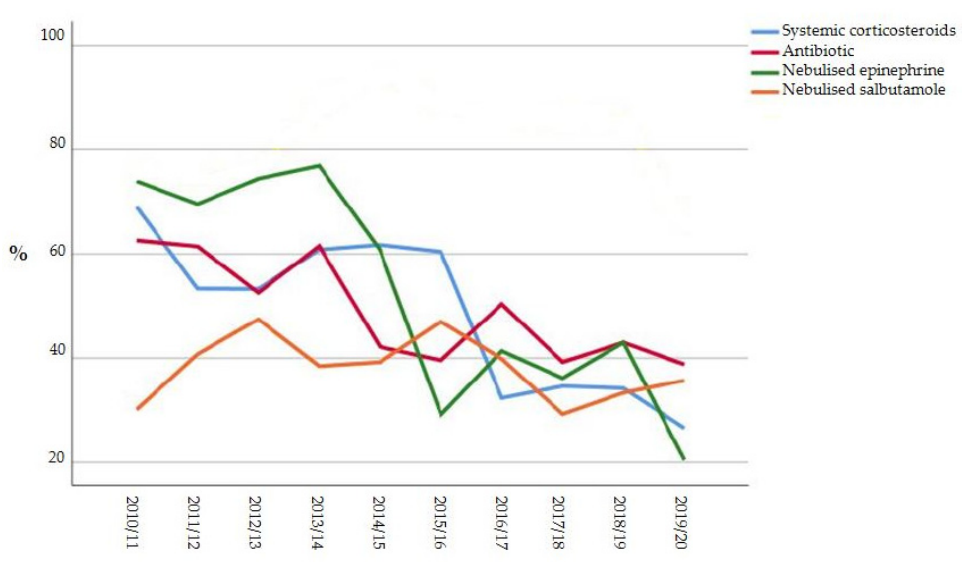
Figure 1. Variation in the use of pharmacologic treatments and CXR over time.